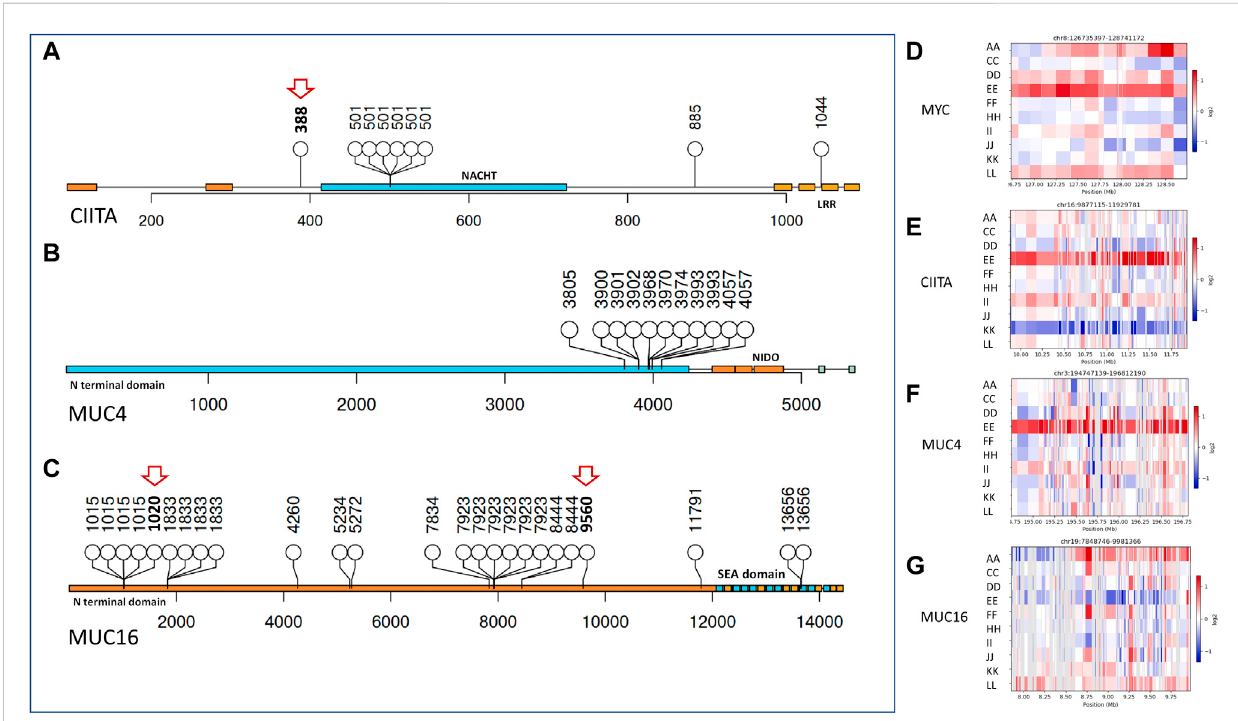
FIGURE 2 Copynumbervariantsandaffectedproteindomainsofimpactedgenes. (A – C) Lollipopplotshowingmutationsaffectingproteindomains(inblocks) and their frequency in CIITA, MUC4, and MUC16, respectively, novel mutations indicated in red arrows. (D – G) Copy number alteration in MYC, CIITA, MUC4,andMUC16acrossovariancancersubtypes(Redshowingcopynumbergainandbluesignifyingcopynumberloss).SampleEshowingmostcopy number gains in the given